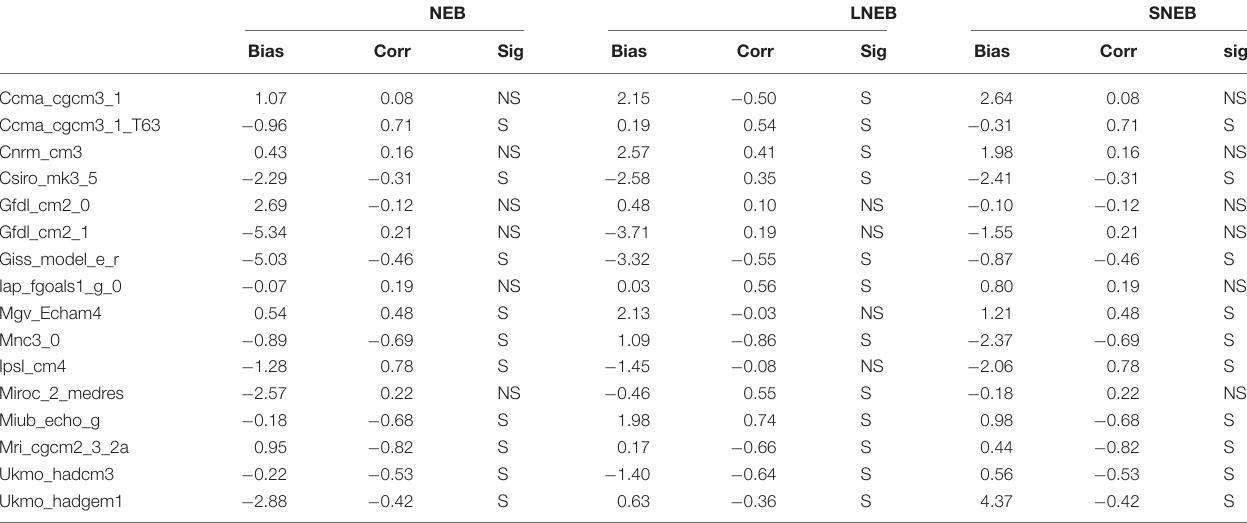
TABLE 2 | Correlation and bias between the autumn rainfall simulated by the CMIP3 models and observations in CMAP. NEB LNEB